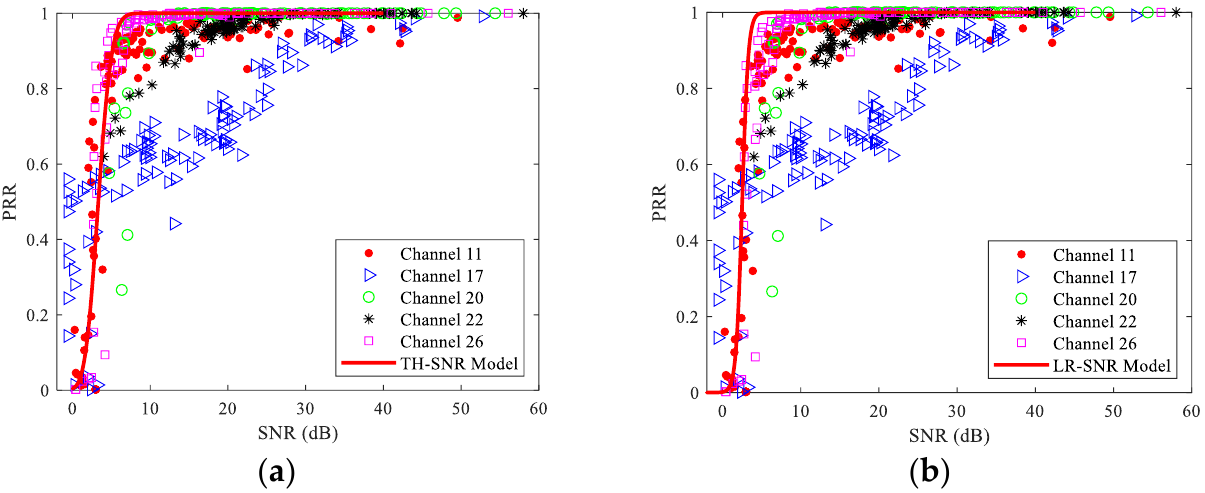
Figure 8. Measured and Estimated SNR and PRR under different channels: ( a ) The TH-SNR model; ( b ) The LR-SNR model.